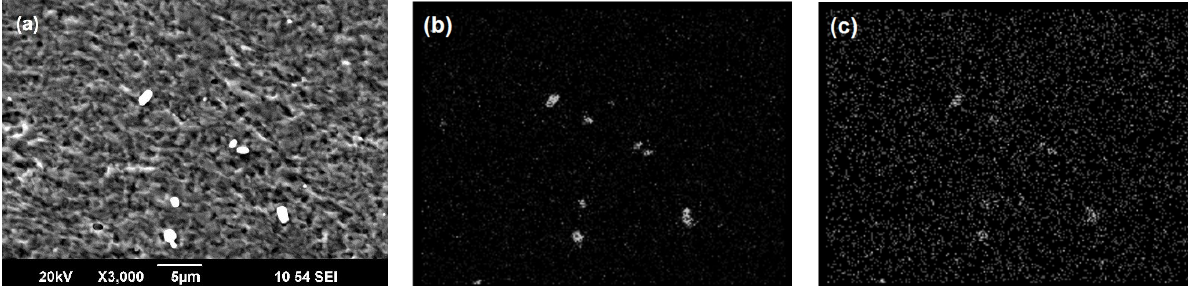
Figure 5: Alloy Cu-0.55Cr-0.2Cd-0.02Zr after eight ECAP cycles + HT at 400 ∘ C for 1 h: a–structure (SEM); b–Cr distribution pattern; c–Zr distribution